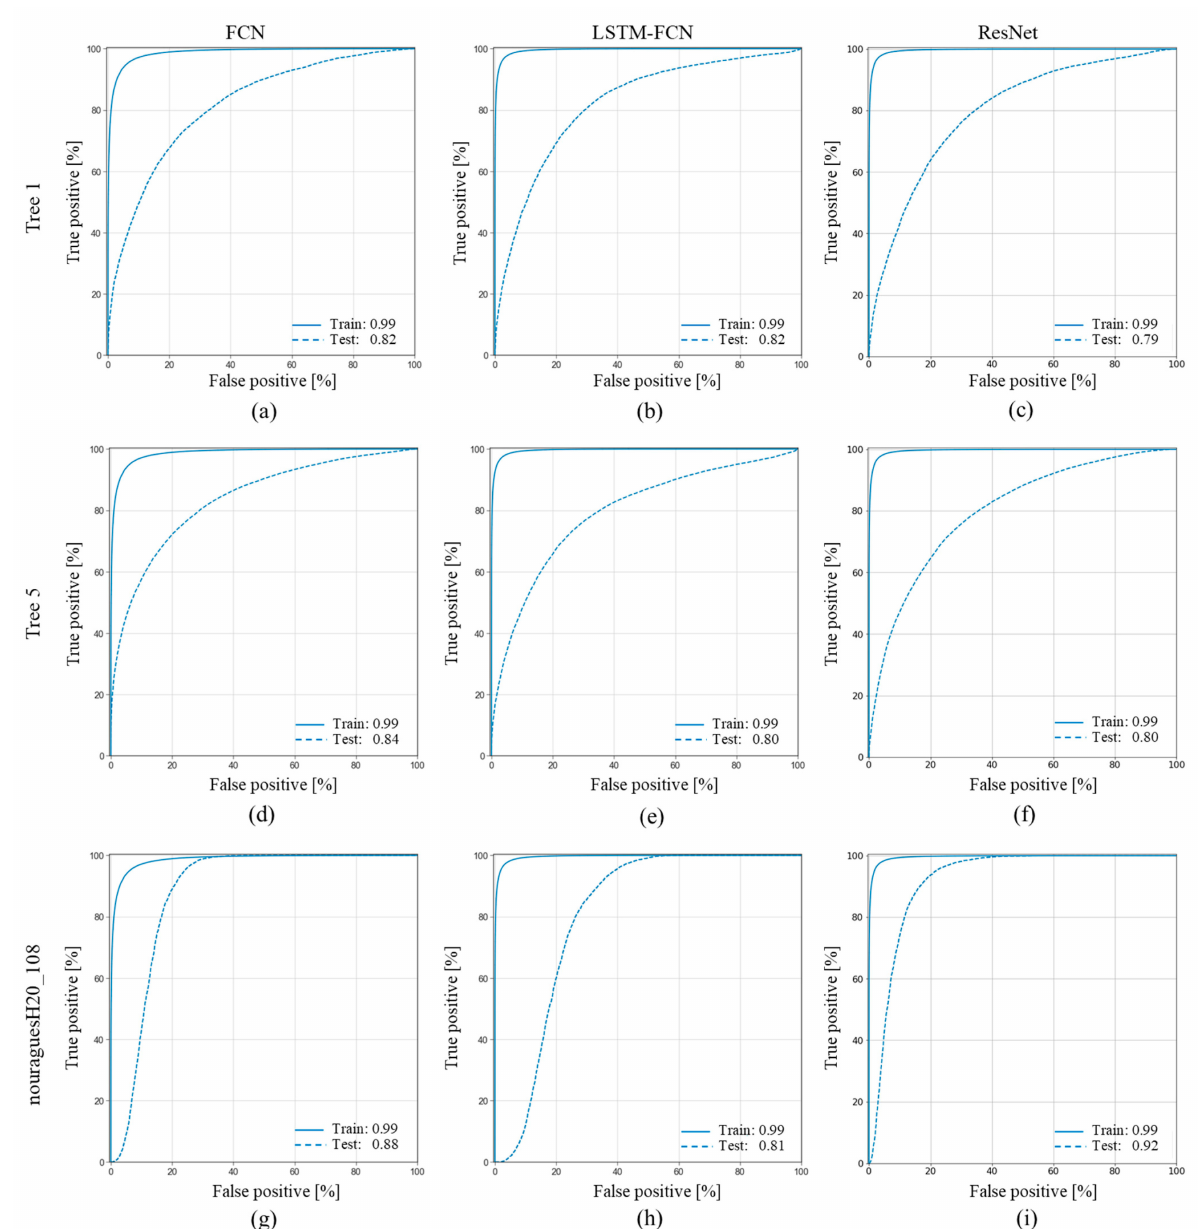
Figure 5. Receiver operating characteristic (ROC) curve for training data and testing data (Tree 1, Tree 5, and nouraguesH20_108) using multivariable time series (MTS) method based on FCN, LSTM-FCN, and ResNet; ( a ) FCN on Tree 1, ( b ) LSTM-FCN on Tree 1, ( c ) ResNet on Tree 1, ( d ) FCN on Tree 5, ( e ) LSTM-FCN on Tree 5, ( f ) ResNet on Tree 5, ( g ) FCN on nouraguesH20_108, ( h ) LSTM-FCN on nouraguesH20_108, ( i ) ResNet on